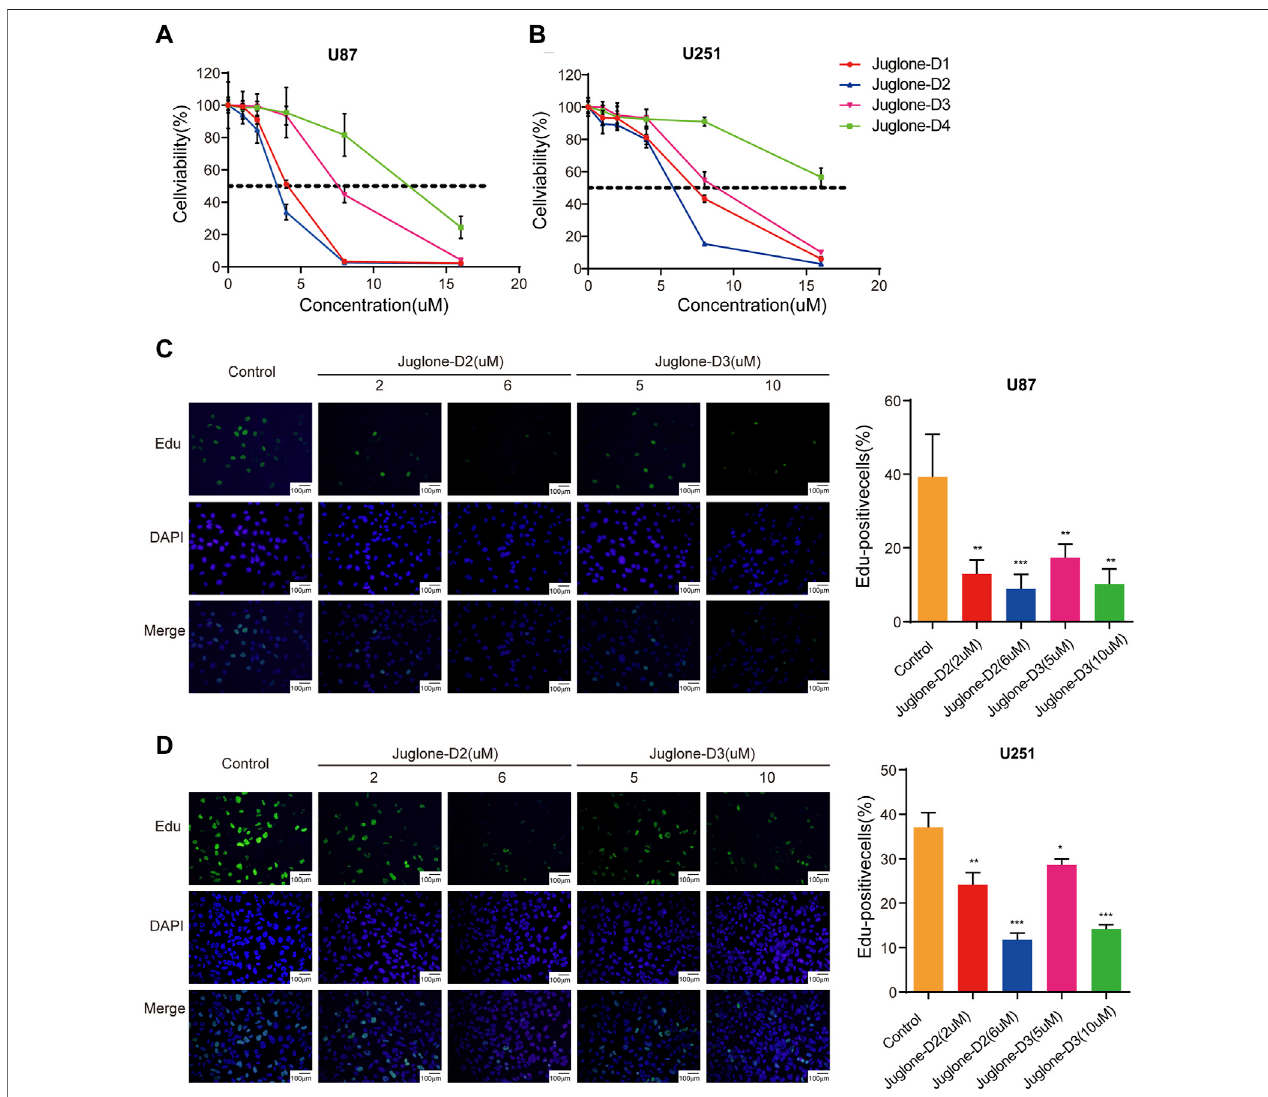
FIGURE3| Juglone derivatives could exertacytotoxic effect against gliomacells. (A-B) CCK-8 assayshowedD1,D2, and D3couldinhibit cellviabilityofU87and U251 cell lines. (C-D) Edu assay revealed D2 and D3 could inhibit the proliferation of U87 and U251 cell lines. * p < 0.05, ** p < 0.01, *** p < 0.001.